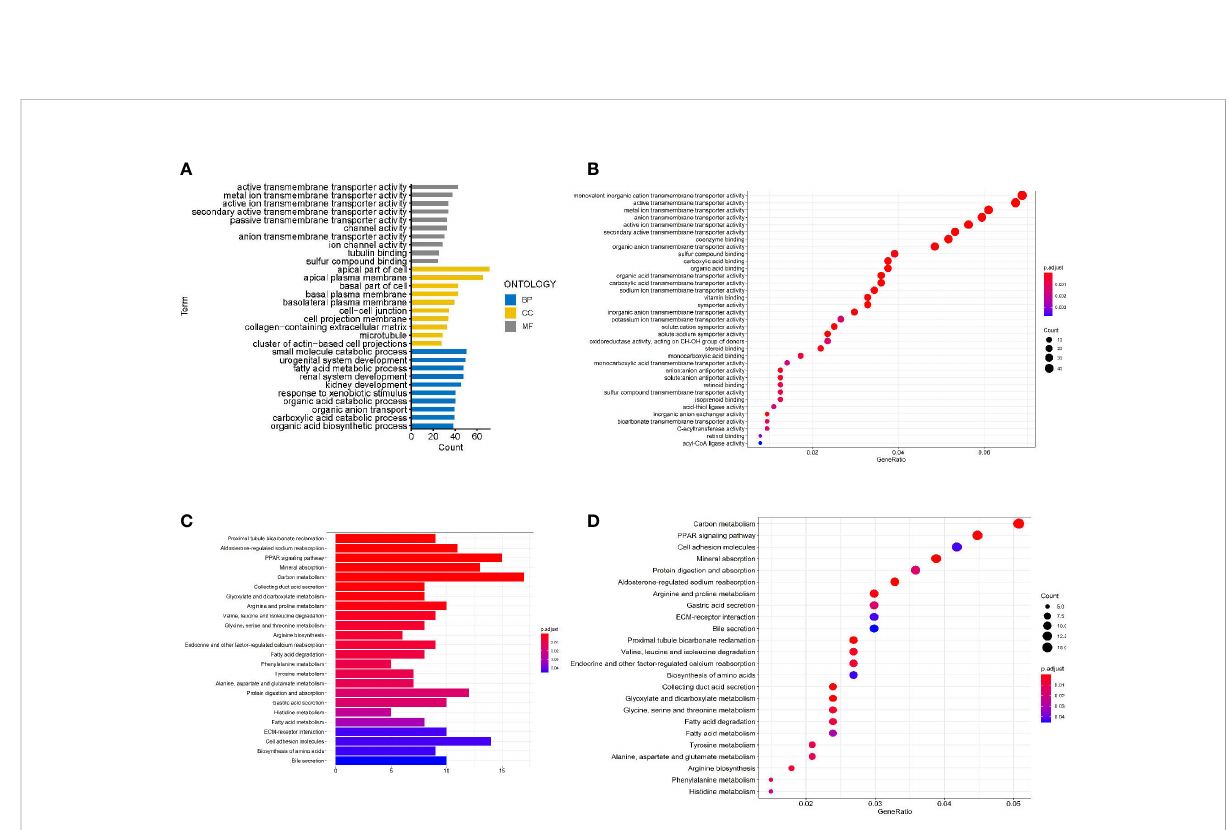
FIGURE 2 Bar charts and bubble map of GO and KEGG pathway analyses. (A) GO enrichment bar chart of DEGs: The 10 most signi fi cant enriched terms in biological process, cellular component, and molecular function are select. (B) GO enrichment bubble map of DEGs. Bubble size represents the number of enriched genes, and bubble color difference represents the signi fi cance of target gene enrichment. (C) KEGG enrichment analysis bar chart of DEGs. The top 24 pathways from the KEGG enrichment analysis ranked by p-value. (D) KEGG enrichment bubble map of DEG.